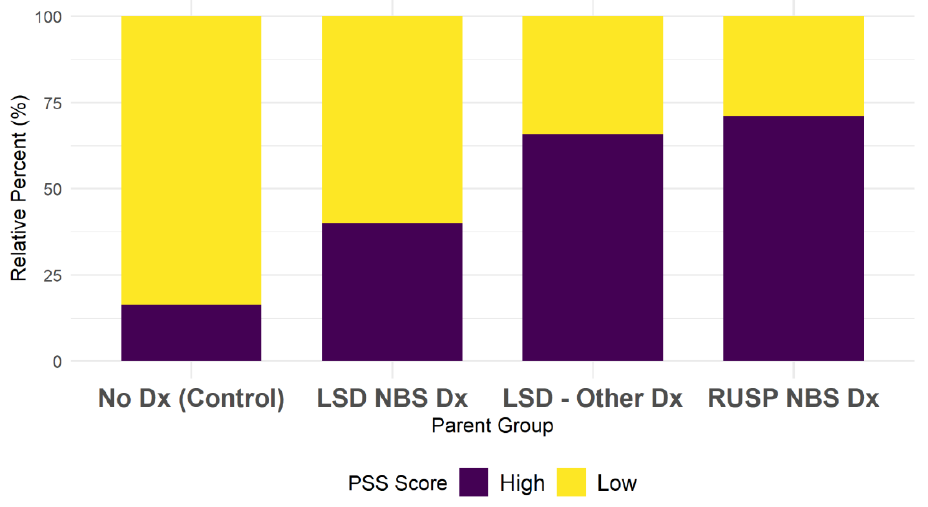
Figure 2. Parental stress scale score outcome by parent